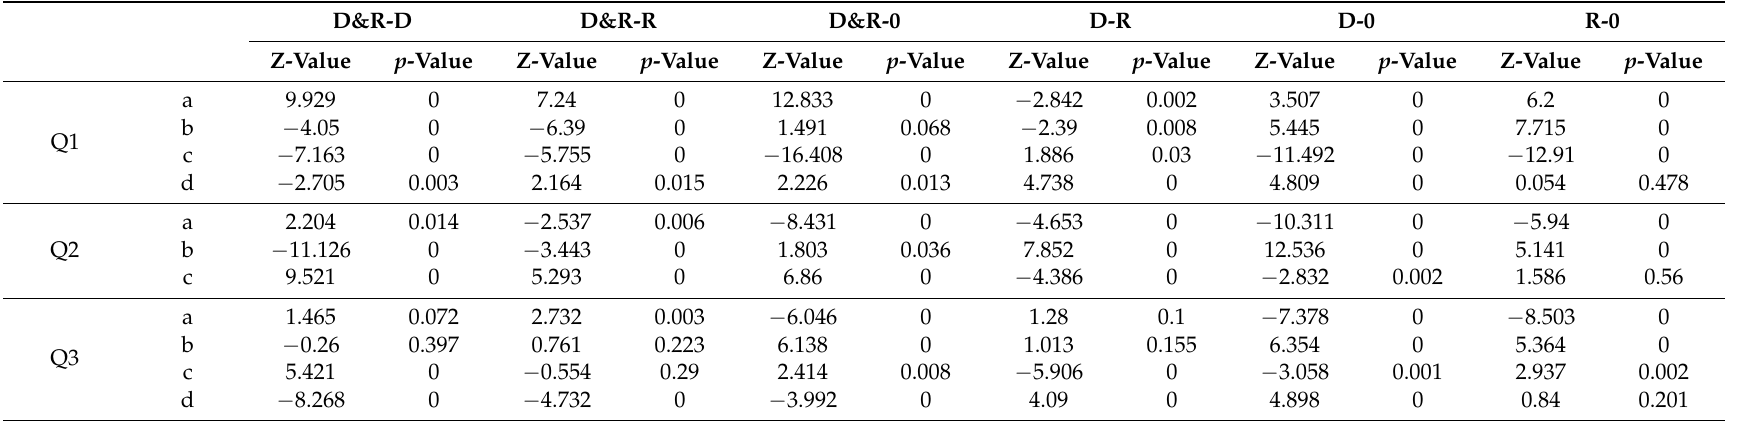
Table 3. The results of the asymptotic (two-sided) z -test for testing the significance of the observed rates inequalities. Bold results are those for which the null